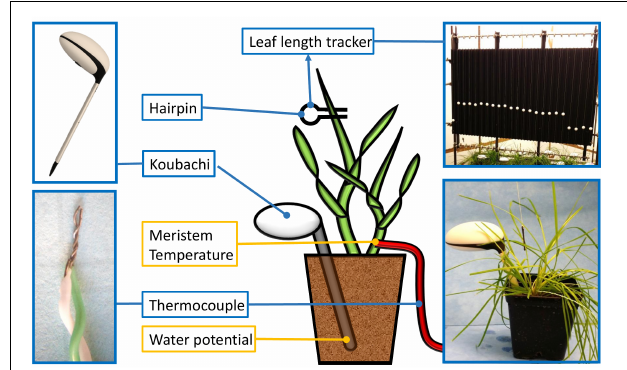
FIGURE 1 | Phenotyping platform for chronological profiling of the leaf elongation rate (LER), the soil water potential and micrometeorological variables. The figure illustrates a perennial ryegrass plant with the following sensors connected: a wireless Koubachi plant sensor used to measure the soil water potential, the Leaf Length Tracker (LLT) used to measure leaf growth over time and a thermocouple used to record the temperature in the meristem